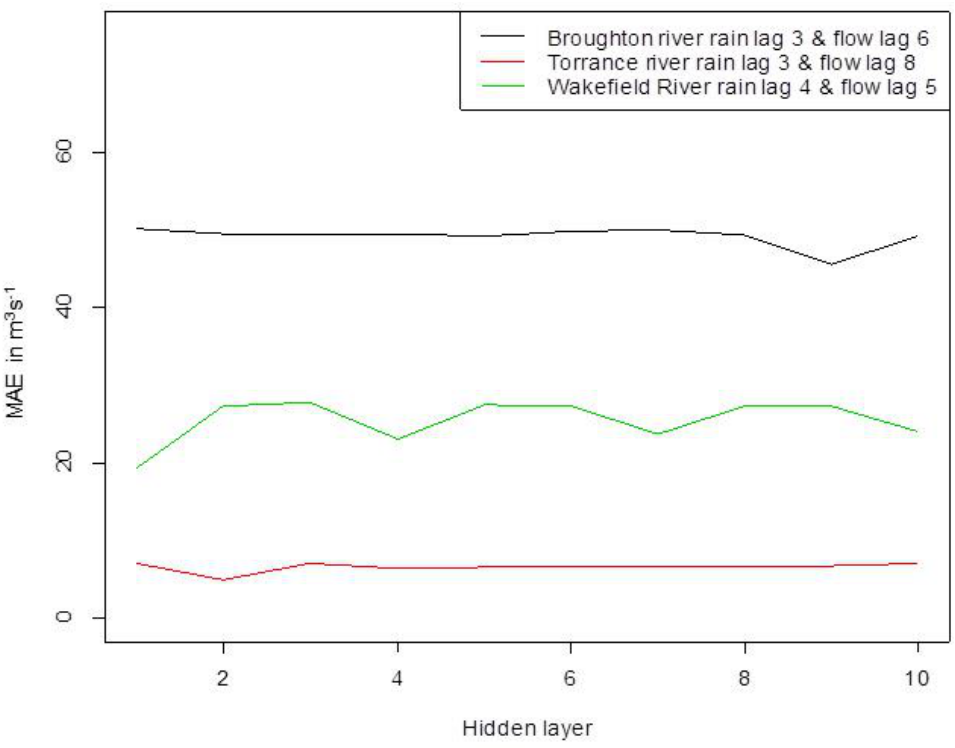
Figure 6. MAE for training data (1990–2009) using ANN with best lag combinations at each location, units in m 3 s − 1